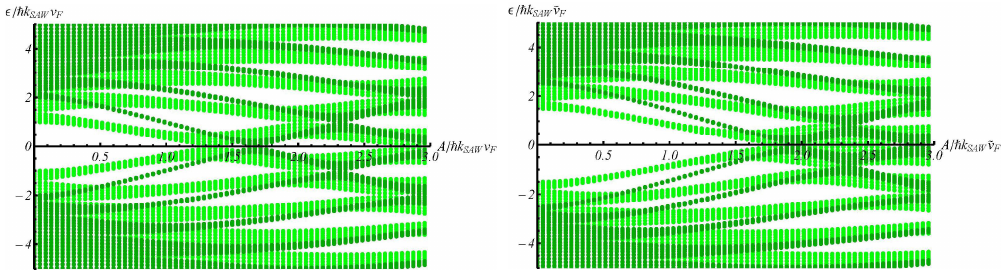
Figure 1. Scaled electron energy spectrum ε ( k ) / ( (cid:126) ˜ v traps as a function of the normalized SAW amplitude A/ ( (cid:126) ˜ v nanoribbons subjected to an acoustically induced SAW potential. In this figure, we choose ∆ / ( (cid:126) ˜ v k ) = 1 . 0 (upper panel) and 1 . 5 (lower panel). Only the eigen-spectra arising F SAW from the two lowest dispersion curves in the absence of an SAW are displayed. Higher subbands contribute significantly at larger SAW amplitude. The lighter shaded regions arise from the lowest energy dispersion curves, whereas the darker shaded regions are associated with the energy dispersions of the next